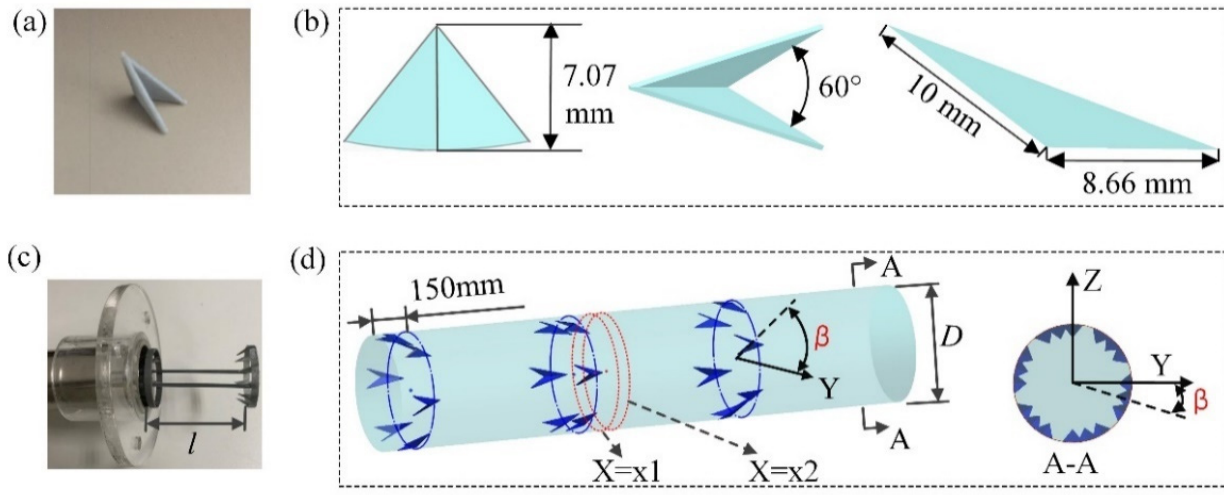
Figure 1. The DWPVG and test section. ( a ) Real photograph of a single DWPVG, ( b ) schematic of DWPVG, ( c ) real photograph of the test section with DWPVGs, ( d ) schematic of the test section.